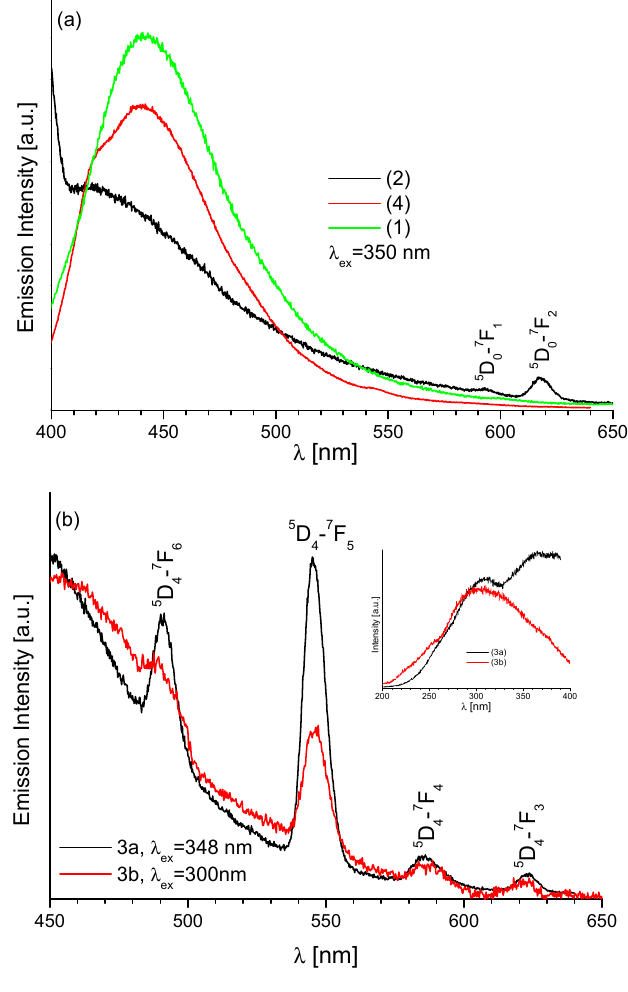
Figure 9. The emission spectra of acetonitrile solution ( a ) (Sm) 1 , (Eu) 2 and (Dy) 4 and ( b ) (Tb) 3a and (Tb) 3b , c = 2 ×·10 − 5 M.